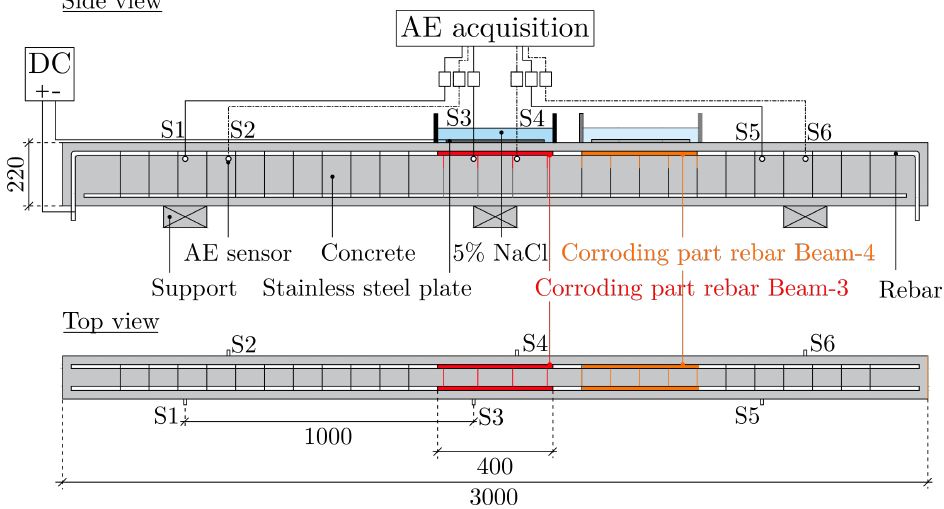
Figure 8. Schematic representation of the accelerated corrosion setup and 2D AE sensor configuration (S1–S6) of the second test series of RC beams (Beam-3 and